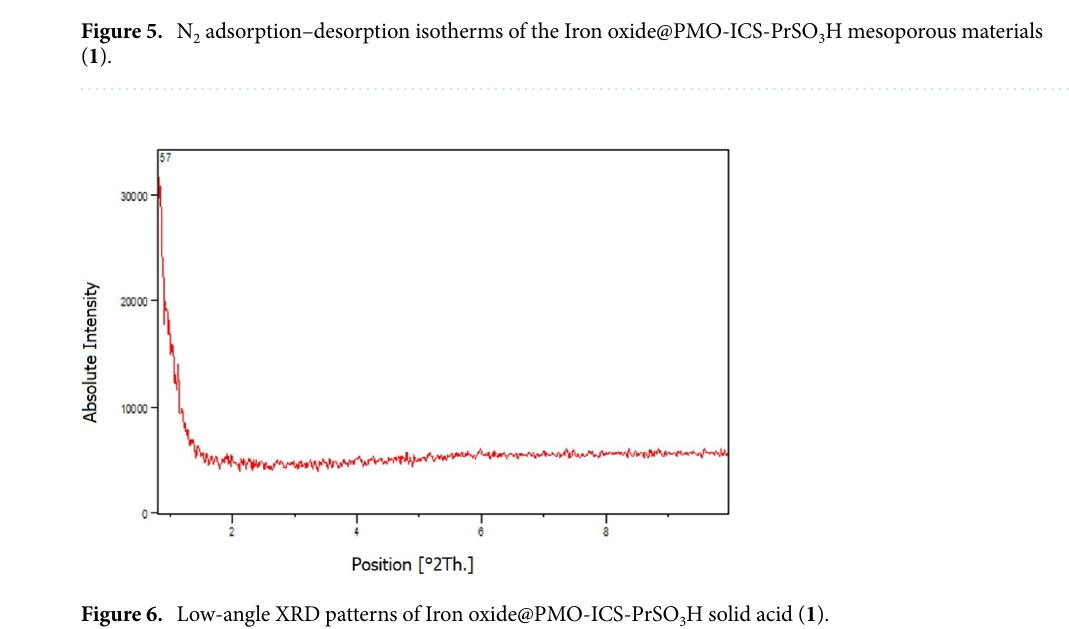
Figure 6. Low-angle XRD patterns of Iron oxide@PMO-ICS-PrSO 3 H solid acid ( 1